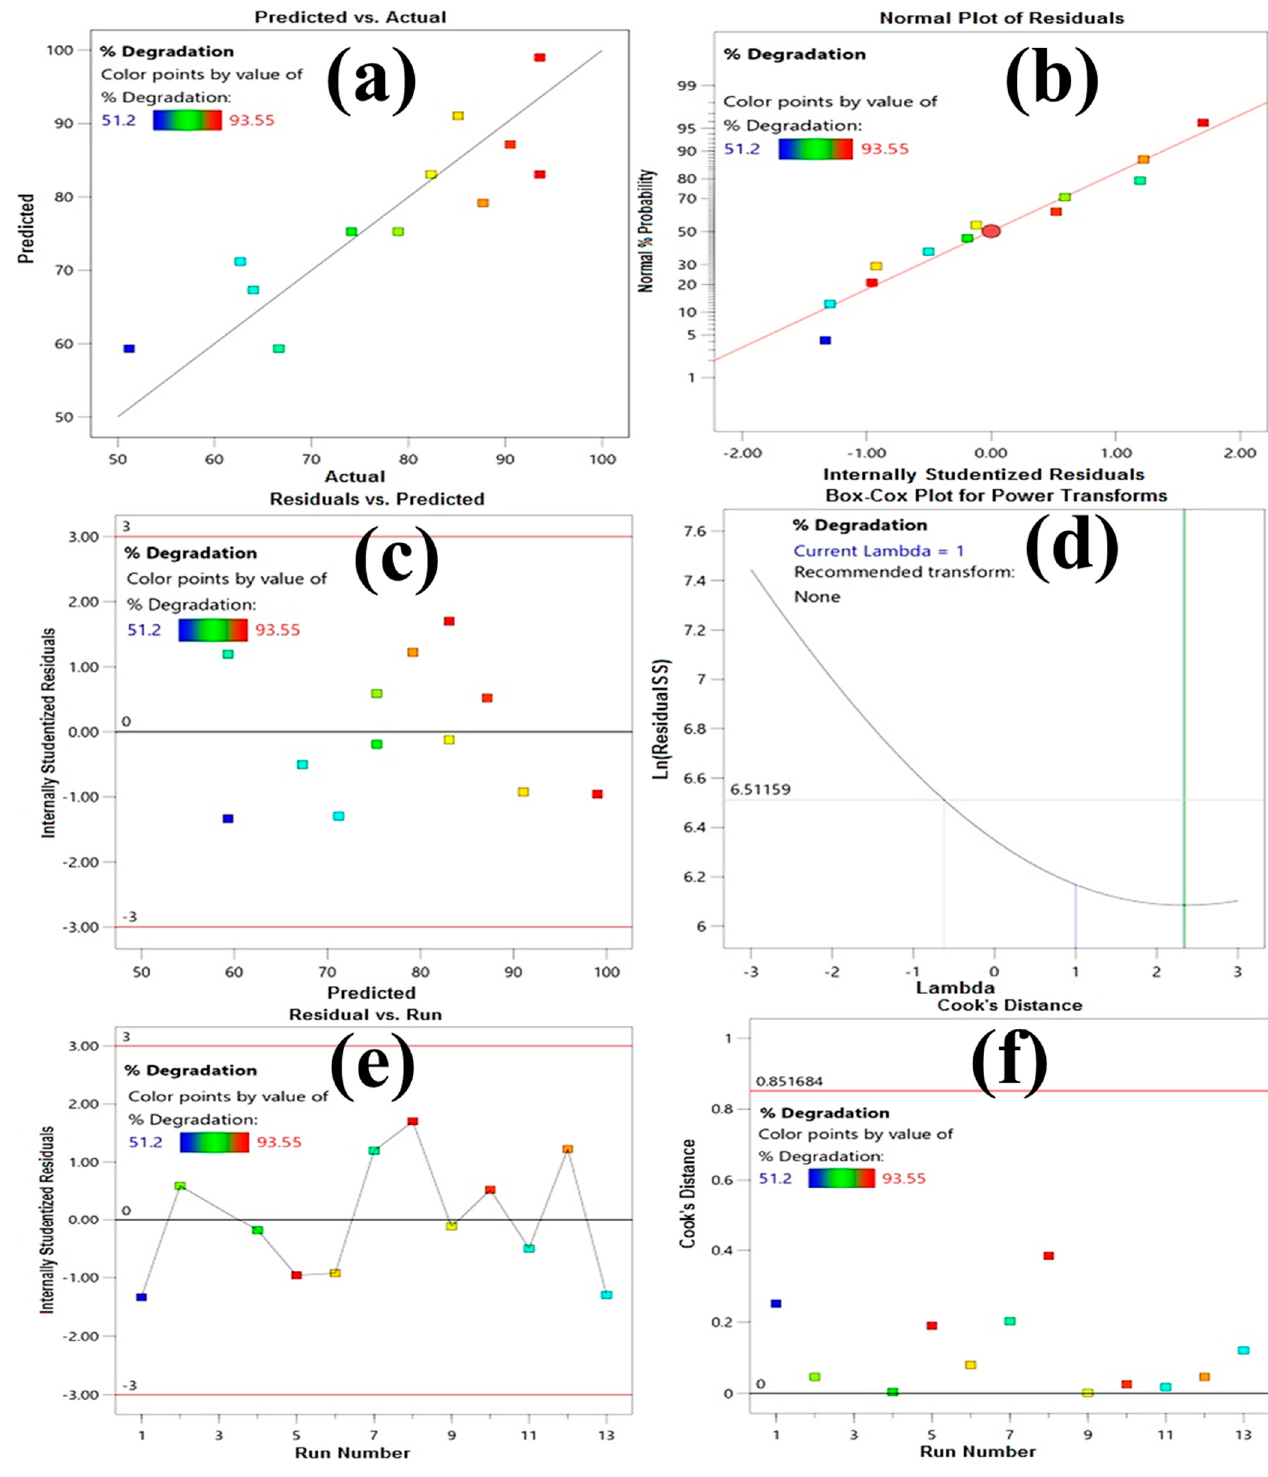
Figure 3. Different Diagnostics Plots for model adequacy: ( a ) predicted vs. actual; ( b ) normal probability; ( c ) internally studentized residuals vs. predicted values; ( d ) Box-Cox; ( e ) Residual vs. Run; and ( f ) Cook’s